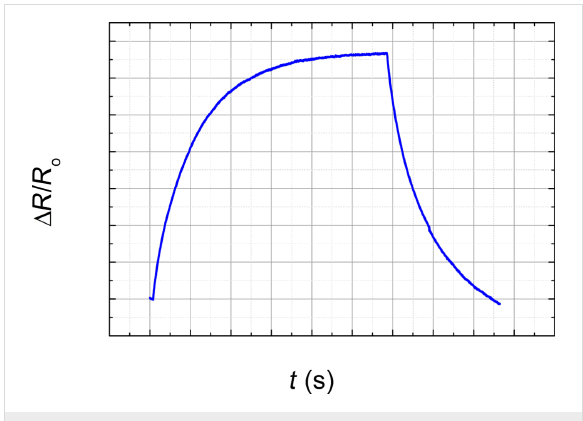
Figure 3: Expected relative electrical resistance change as a function of time in which the curve approaches saturation.